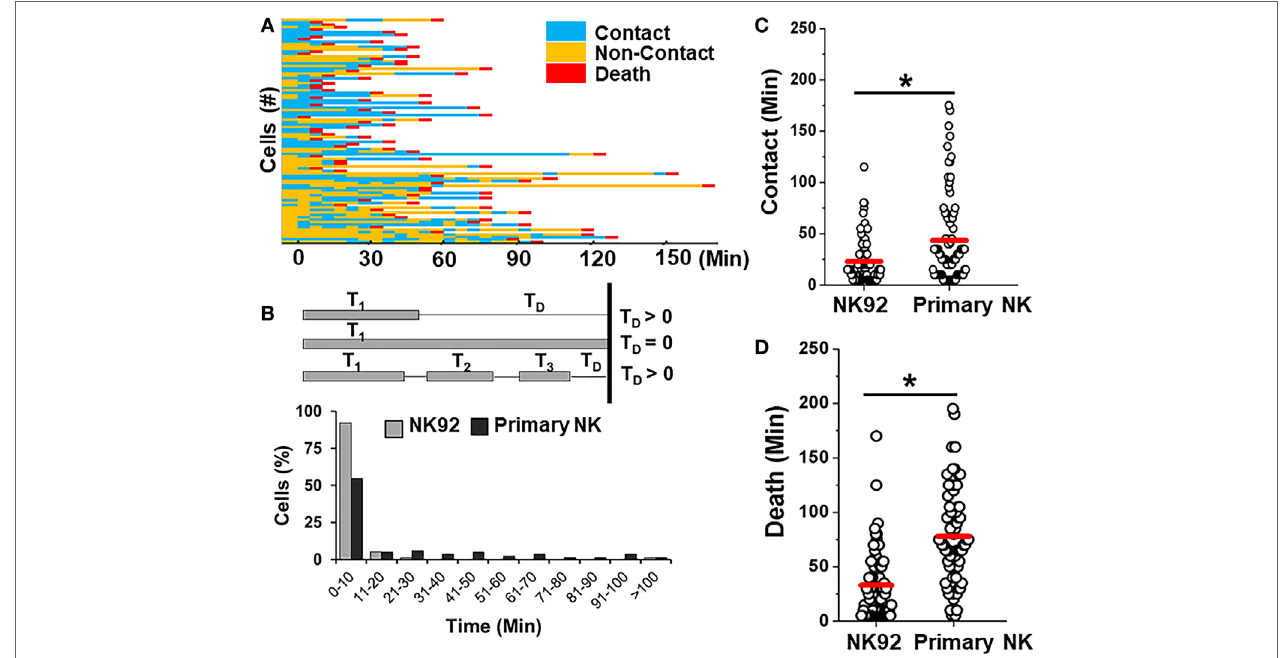
FigUre 7 | Comparison of killing efficiency of primary natural killer (NK) cells with NK92 cells. (a) Representative heat map showing periods of contact (blue), non-contact (yellow), and death (red) during NK92 cell interaction with SUDHL10 cells. (B) Schematic illustrating delay time (T D ) calculation and T D detected for SUDHL10 cells from pooled data. (c) Distribution of contact duration between different types of NK cells and SUDHL10 target cells in droplets (* indicates p < 0.0008). (D) SUDHL10 cell death mediated by NK92 cell line and primary CD56 + NK cells. The mean value of each distribution in (c,D) is indicated by the red line. Cell pairs evaluated for NK92: 77; Primary NK: 76 from two independent